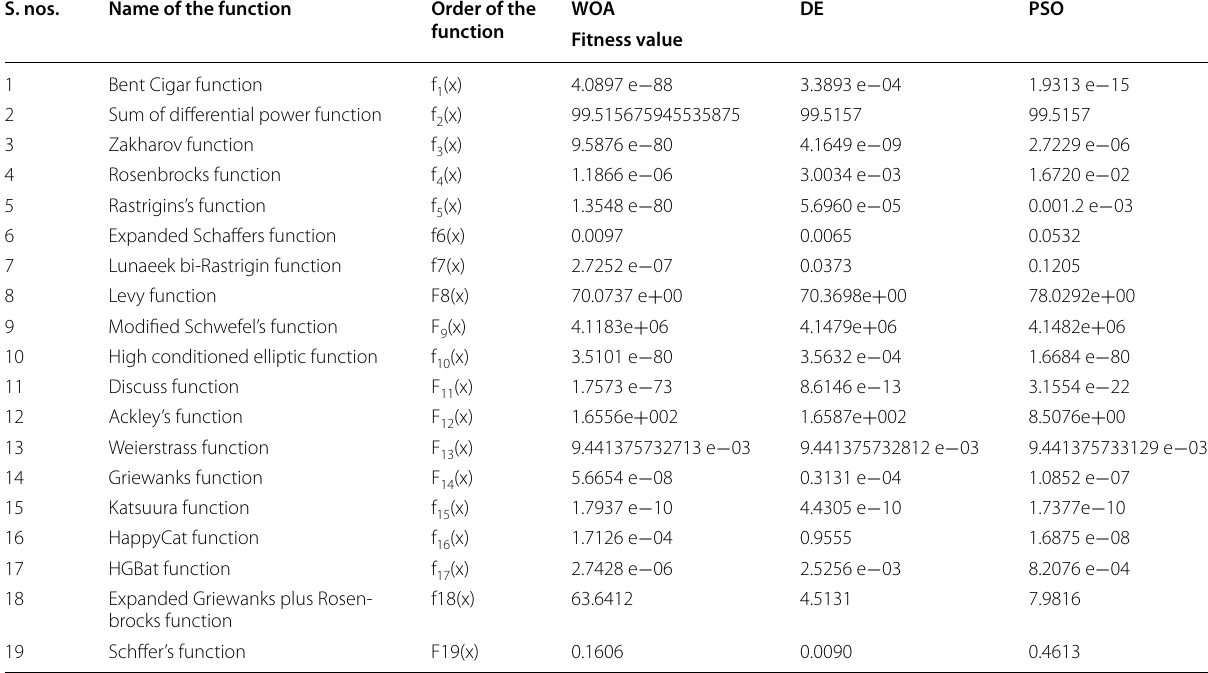
Table 5 Test results of CEC 17 test functions S.